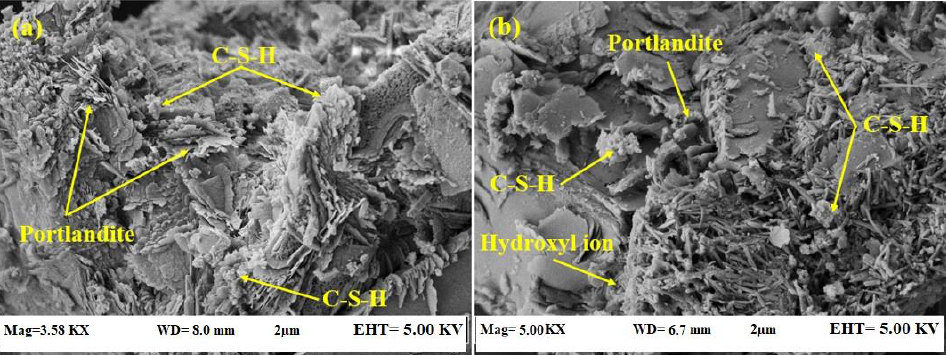
Figure 9. SEM micrographs of the ( a ) control and ( b ) 10% epoxy based mortar.